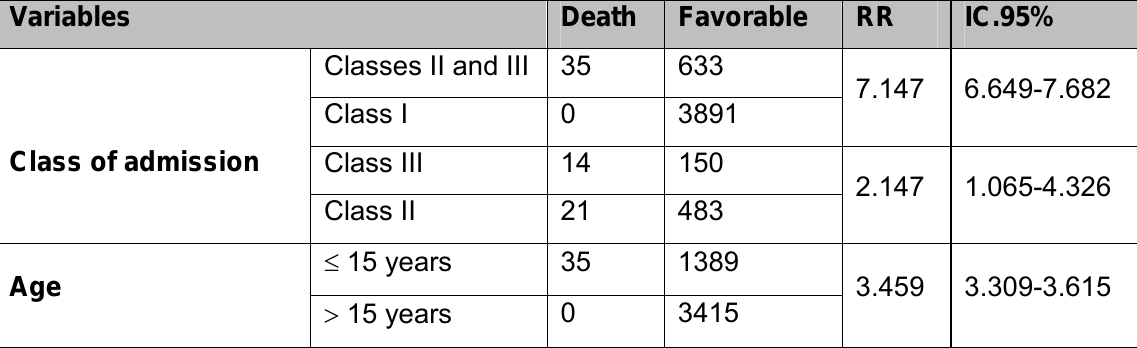
Table 3. The relative risk of death by age and class of